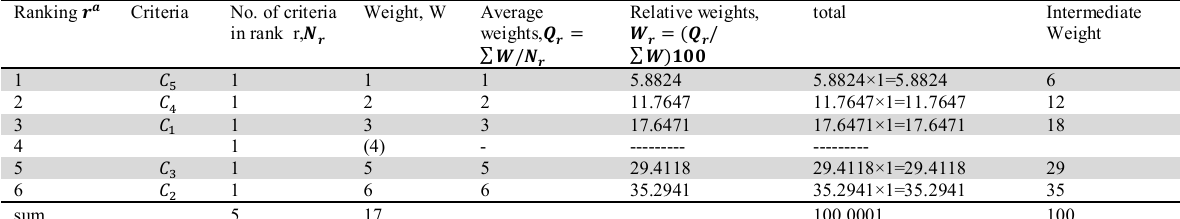
Simos Method for calculating criteria weights